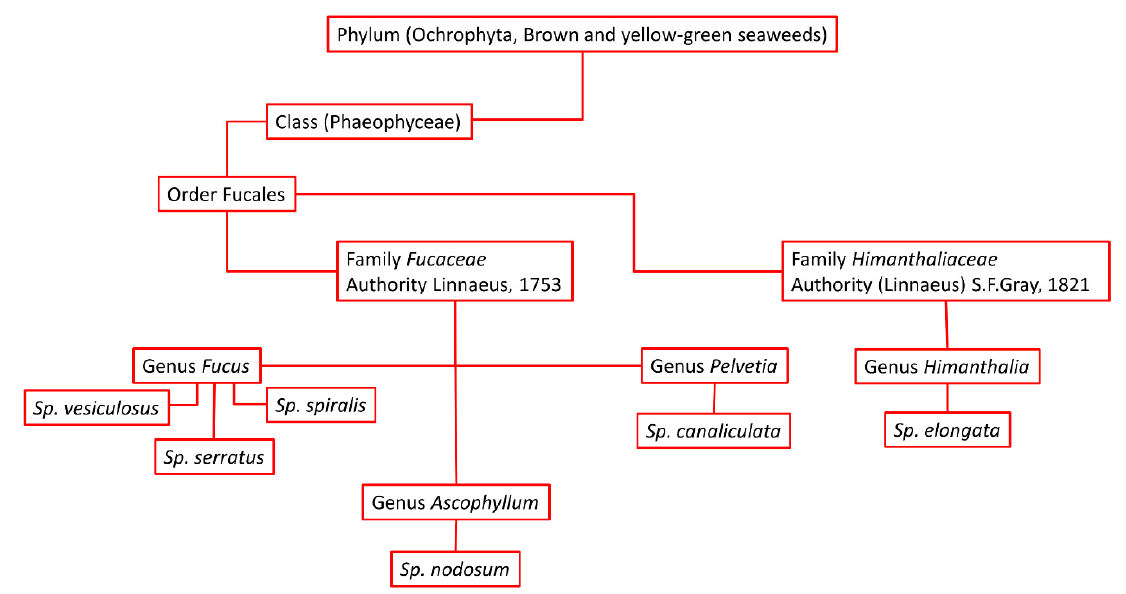
Figure 1. The taxonomic order of the brown seaweeds, “the wracks”, which are widely distributed in Scotland. 1.2. The Biodiversity of the Brown Seaweed Habitat and Their Ecological Importance